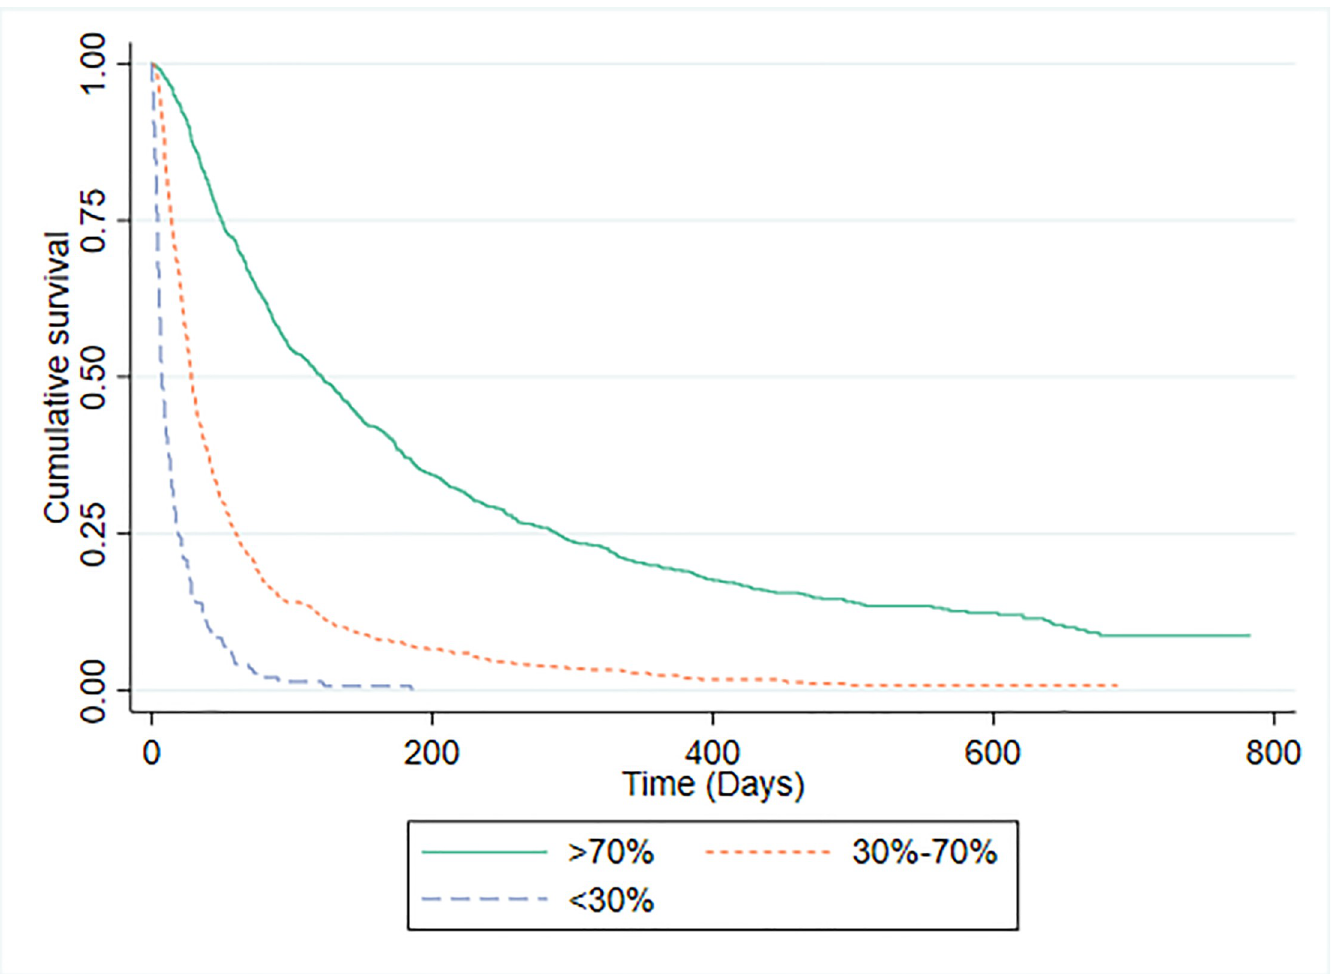
Fig 1. Kaplan-Meier survival curves for PaP risk